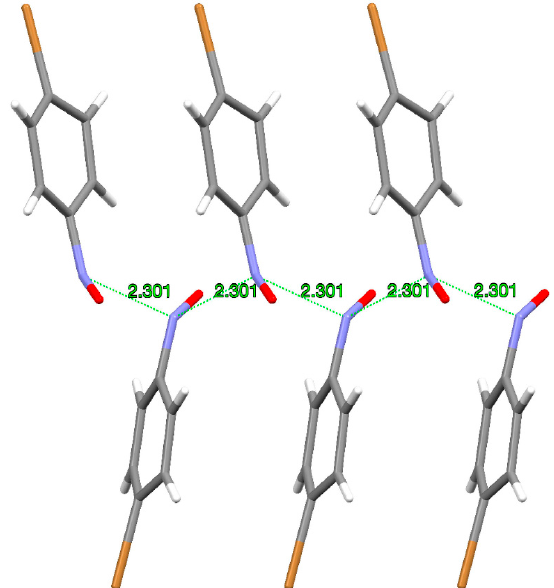
Figure 4. Molecular arrangement of p -bromonitrosobenzene monomers in the metastable crystal after the photochemical single-crystal-to-single-crystal transformation at 100 K.